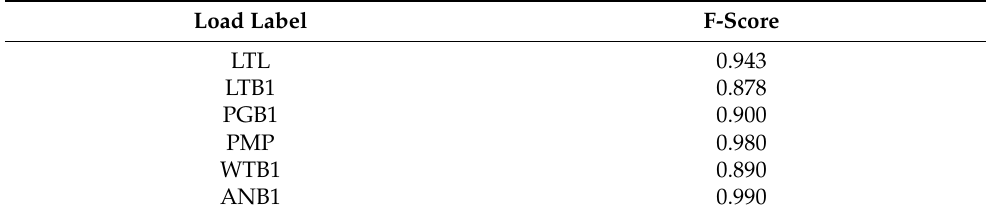
Table 10. Power states classification performance by F-score based on the MTR